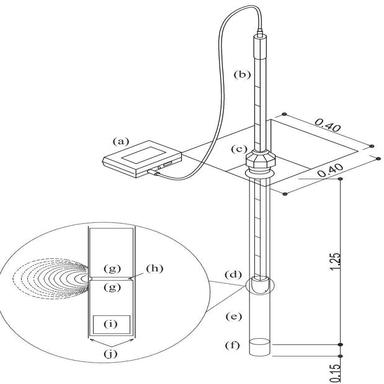
Schematics of the portable ''Diviner 2000" device and access tube (adapted from). (a) Diviner 2000 display unit. (b) Probe rod. (c) Probe cap. (d) Sensor. (e) Access tube. (f) Expandable bung. (g) Electrode. (h) Gap between electrodes. (i) Oscilator. (j) Access tube.